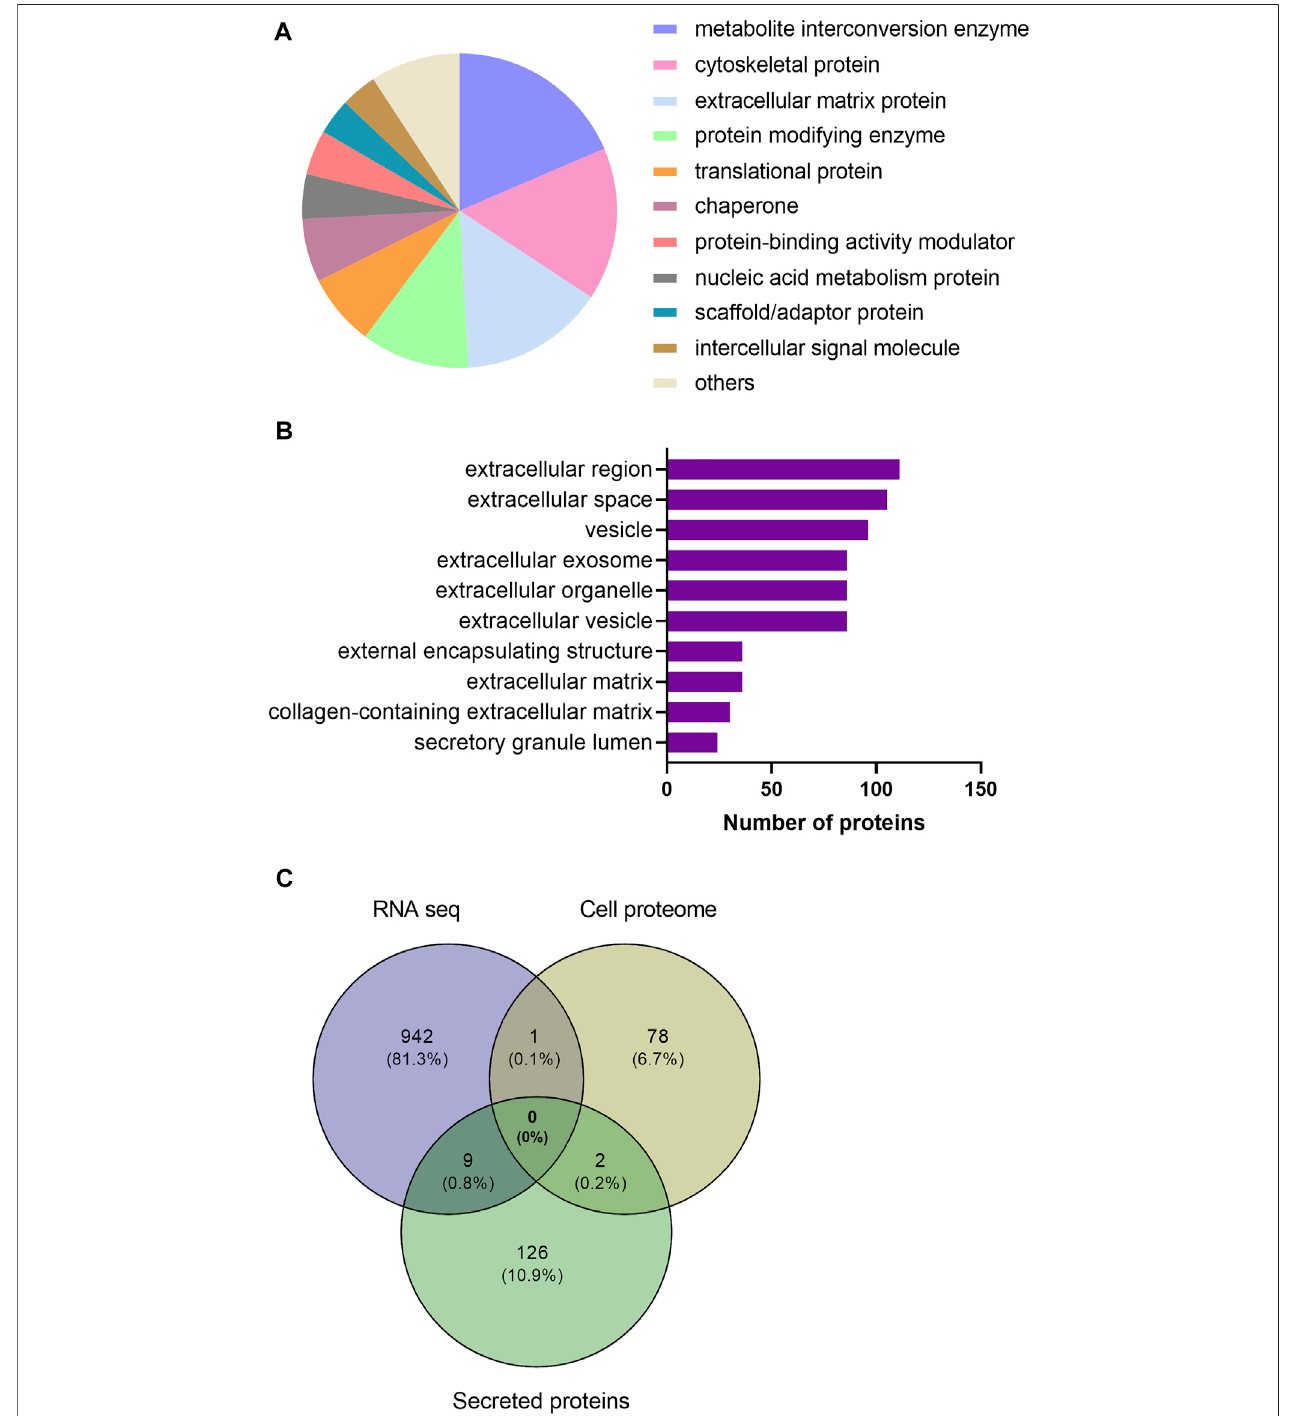
FIGURE 5 | Categorization of signi fi cantly regulated secreted proteins after electrical pulse stimulation (EPS protocol 1) of human myotubes obtained from young male subjects based on protein class and Gene Ontology (GO) enrichment analysis. (A) Secreted proteins grouped based on PANTHER protein class (B) GO cellular component terms overrepresented by EPS-regulated secreted proteins. (C) A Venn diagram analysis of regulated proteins and genes identi fi ed by proteomic and RNA sequencing (RNA seq) analysis. The intersection of the circles represents overlapping proteins and genes among the cell proteome, secreted proteins and transcriptome from the three